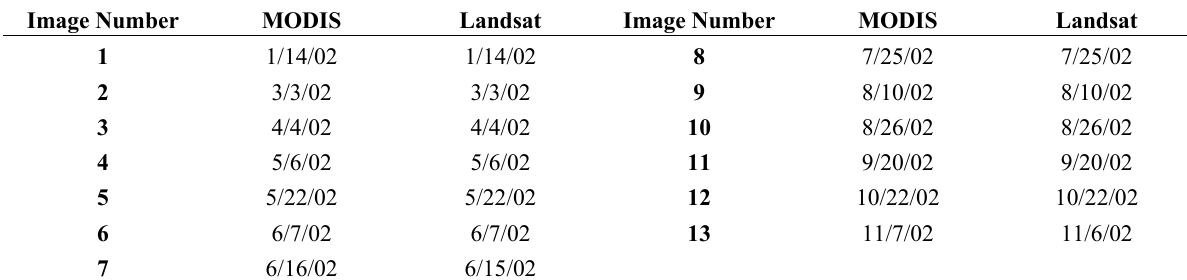
Table 3. Image dates used for the MODIS and Landsat applications to the Middle Rio Grande corridor for year